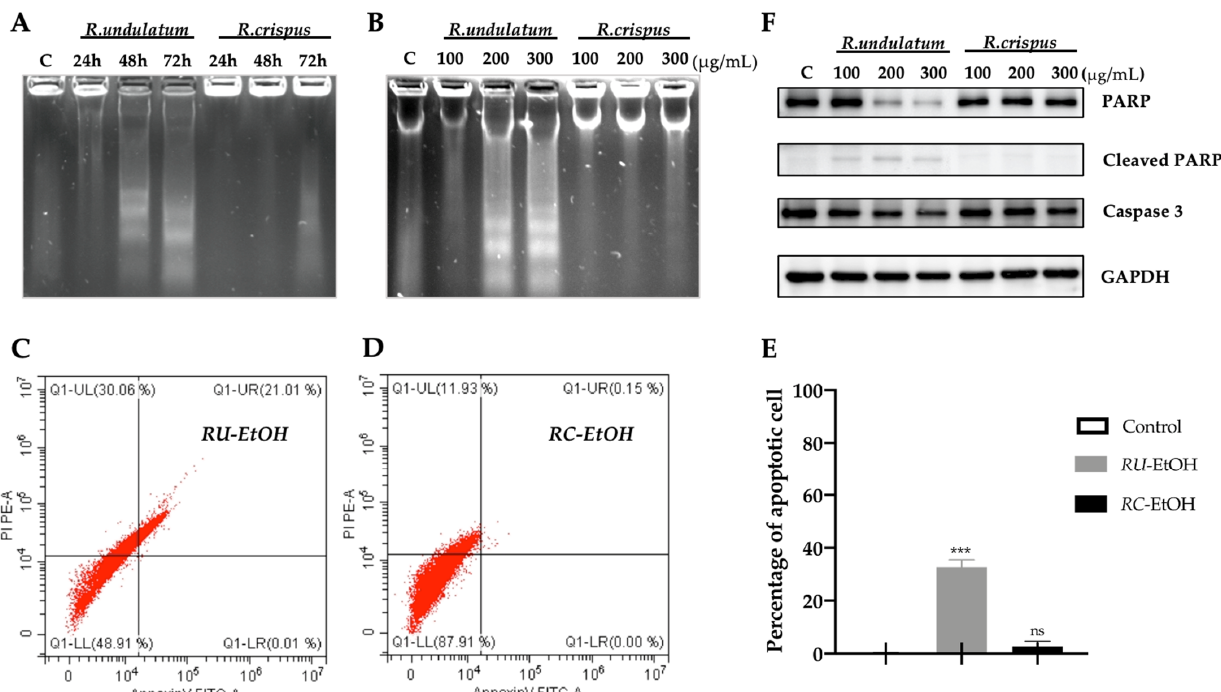
Figure 2. RU , not RC , induces significant apoptosis responses in human hepatocellular carcinoma cell line HepG2. DNA fragmentation using agarose gel electrophoresis of DNA isolated from HepG2 cells treated with either RU -EtOH or RC -EtOH ( A , B ). Annexin V-FITC/PI flow cytometric shape of HepG2 cells, 48 h post-treatment of the ethanol extracts of RU ( C ) and RC ( D ). Compared with negative control (DMSO), apoptotic percentage of the total cell population was presented and given as mean ± SD ( n = 3) *** p <0.0001; ns: not significant ( E ). Effects of different concentrations of RU -EtOH and RC -EtOH on the protein expression responsible for apoptosis in HepG2 cells. GAPDH was used as an internal control ( F ).